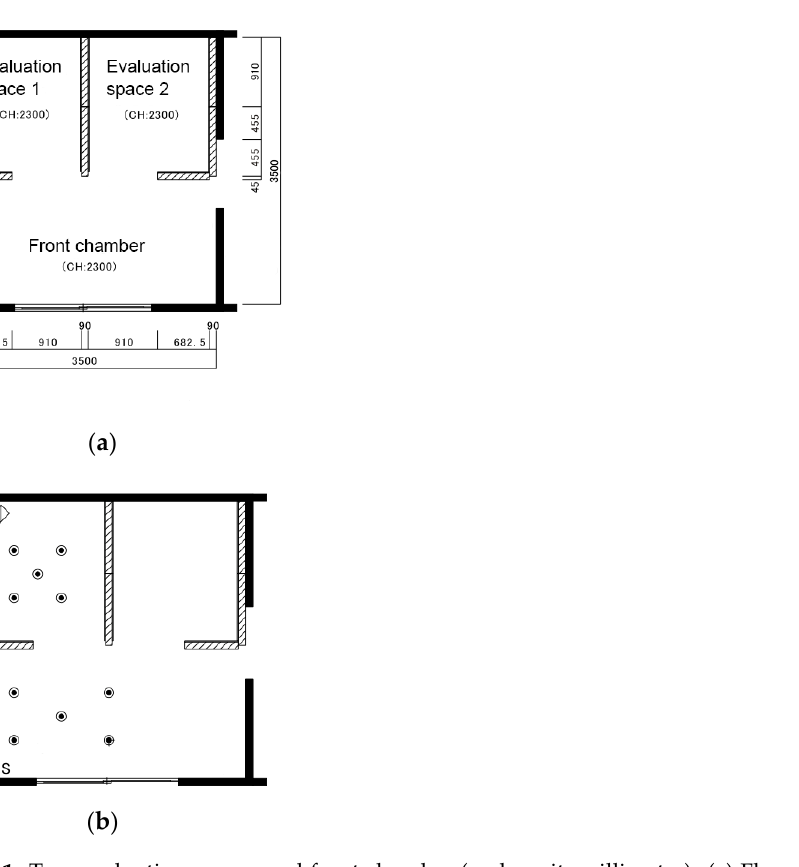
Figure 1. Two evaluation spaces and front chamber (scale unit: millimeter). ( a ) Floor plan of the full-scale model for the subjective experiment; ( b ) loudspeaker and microphone positions for the reverberation time measurements.